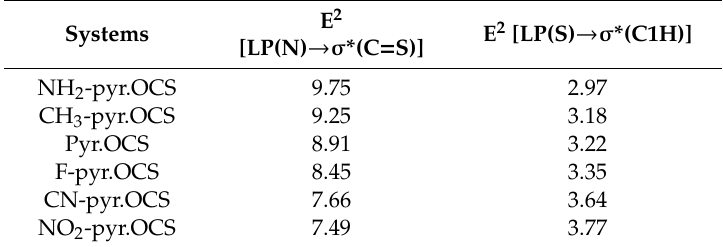
Table 5. Most predominant hyperconjugation energies (kJ / mol) in the A complexes of pyridines.OCS.